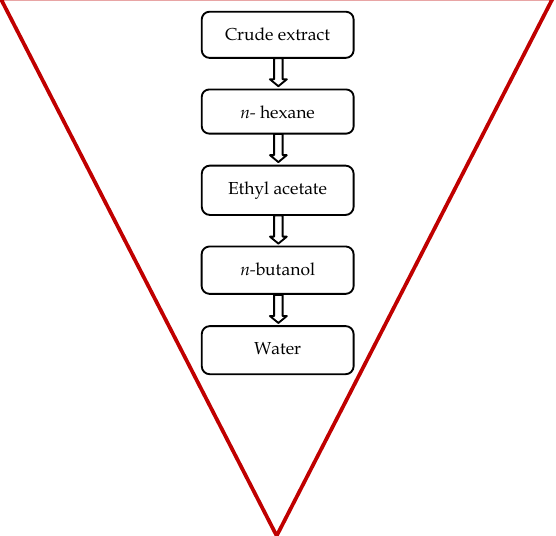
Figure 1: Flow chart of solvents arranged on ascending order of polarity used during experiment